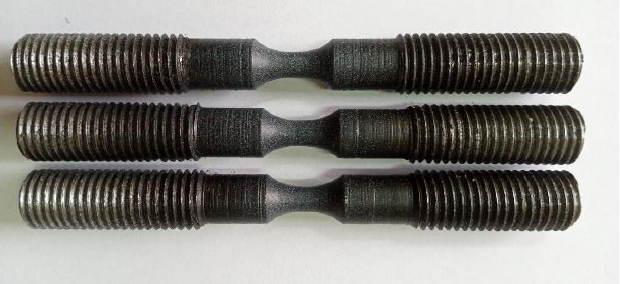
Figure 2. The general appearance of experimental metal specimens after drawing a dot pattern.